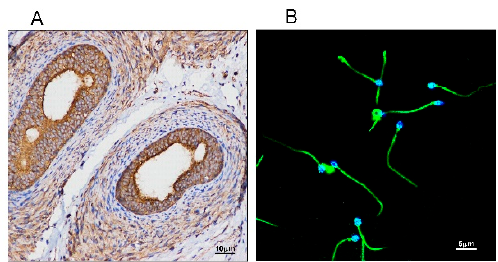
Figure 1. The distribution of sphingomyelin synthase 2 (SMS2) in testes and sperm. ( A ) Analysis of SMS2 protein levels in a human testis by immunohistochemistry; ( B ) analysis of SMS2 in human sperm by immunofluorescence.